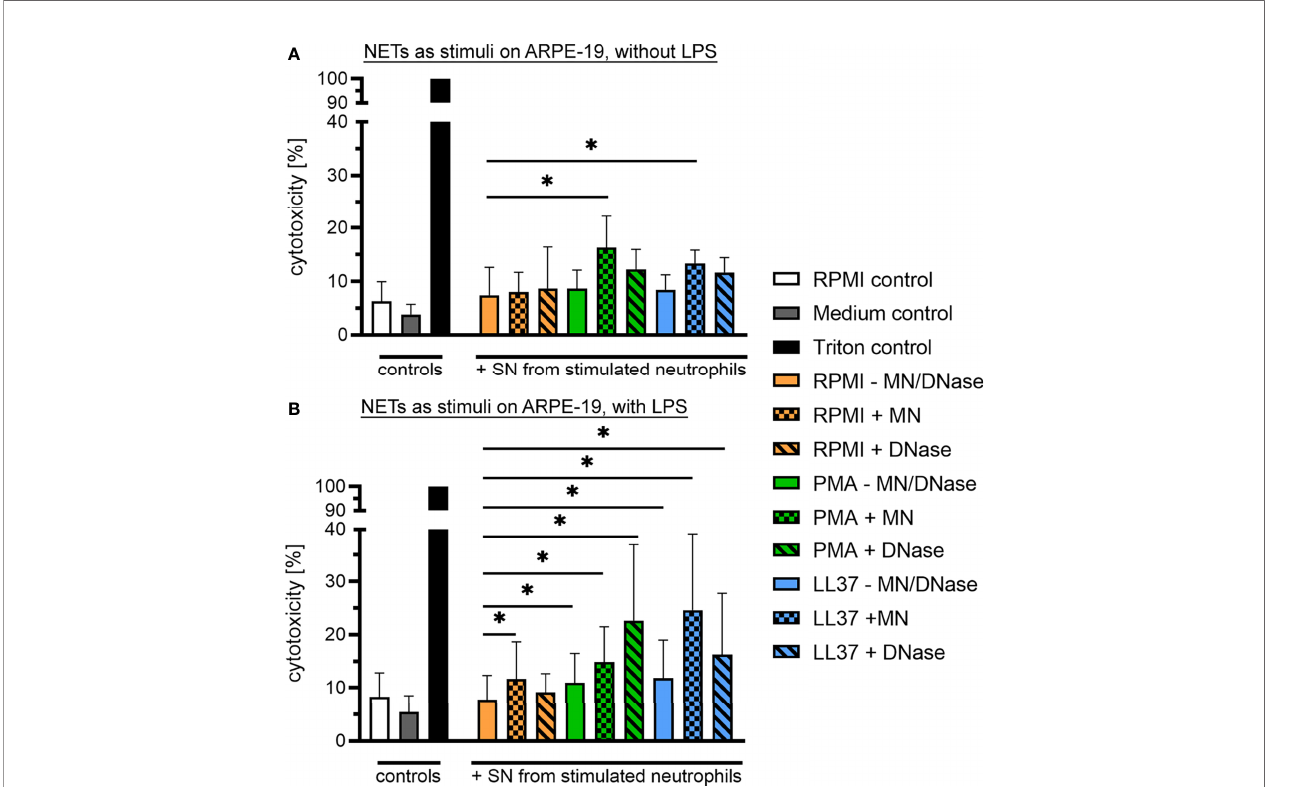
FIGURE 6 | Cytotoxic effect of human NETs on retinal pigment epithelium (RPE) cells. (A) Con fl uent ARPE-19 cells were exposed to supernatants of unstimulated human neutrophils (PMN) or NETs, induced by either phorbol myristate acetate (PMA) or the human cathelicidin LL-37. All variants were tested undigested, partially (micrococcal nuclease, MN) and completely (DNase I) degraded (n=6). Cytotoxicity was measured via the release of lactate dehydrogenase (LDH) by ARPE-19 cells. The bars represent mean ± SD. A one-tailed Wilcoxon matched-pairs signed rank test was performed. p values of * p < 0.05 were considered signi fi cant, comparing each stimulus with the neutrophils in RPMI setup. A signi fi cantly higher cytotoxicity towards ARPE-19 cells was measured after exposition to MN-digested NETs, induced by either PMA or LL-37 ( p < 0.05). (B) Furthermore, the cytotoxicity of all stimuli was evaluated in presence of lipopolysaccharide (LPS; n=6). The bars represent mean ± SD. A one-tailed Wilcoxon matched-pairs signed rank test was performed. p values of * p < 0.05 were considered signi fi cant, comparing each stimulus with the neutrophils in RPMI setup. A signi fi cantly higher cytotoxicity towards ARPE-19 cells was measured after exposition to undigested, MN-digested and DNase I-digested NETs in presence of LPS, induced by either PMA or LL-37 ( p < 0.05). In addition, a signi fi cant higher LDH-release was measured after incubation with supernatants of neutrophils incubated with